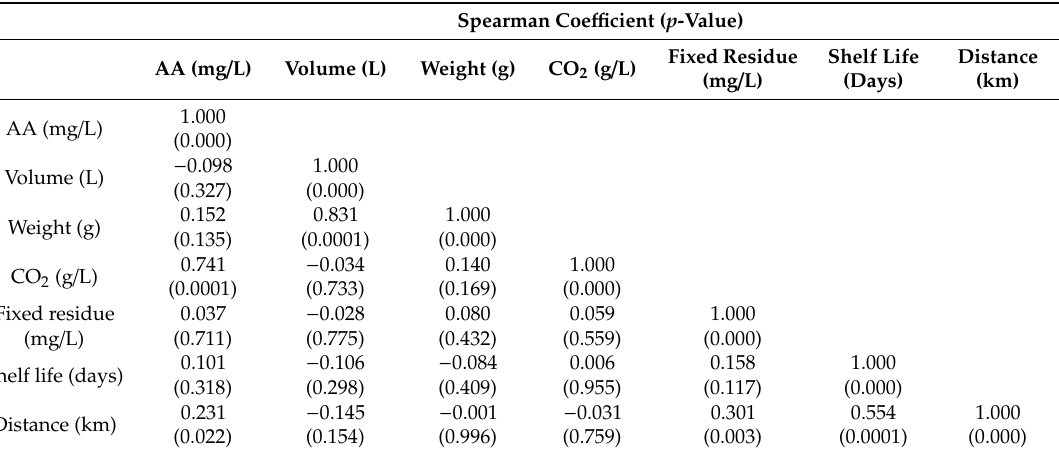
Table 2. Correlations between acetaldehyde (AA) concentrations and other parameters of the mineral water samples.